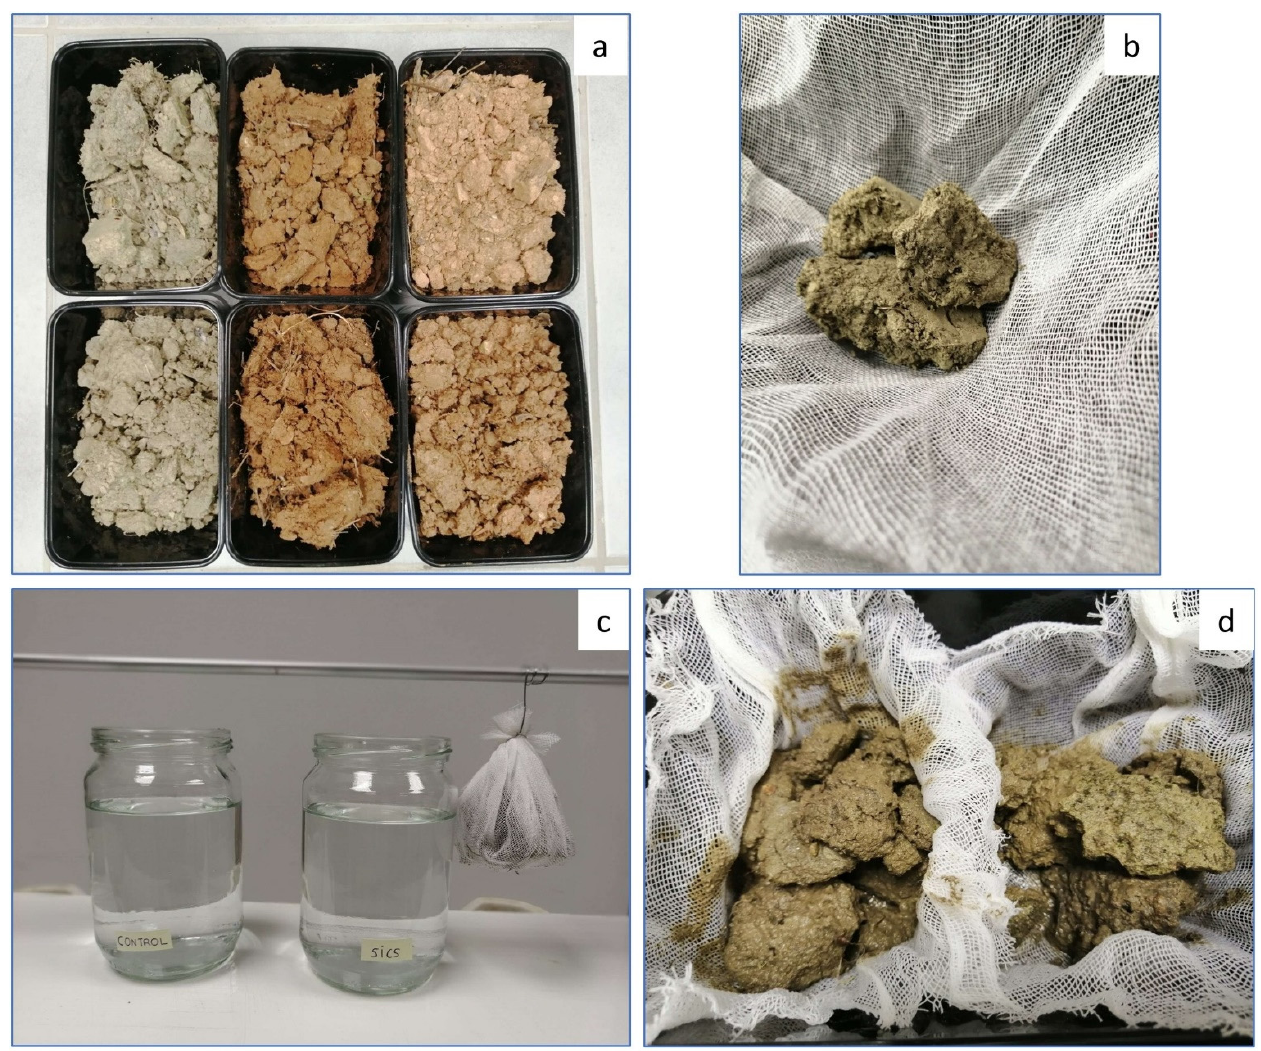
Figure 3. ( a ) Soil aggregates from both plots (control and SICS) of the three study sites: air-drying before slaking test, ( b ) 100 g of three aggregates of the Astrikas field to be used for the slaking test, ( c ) soil aggregates into the mesh before being immersed to water, and ( d ) soil aggregates after the immerse to water.